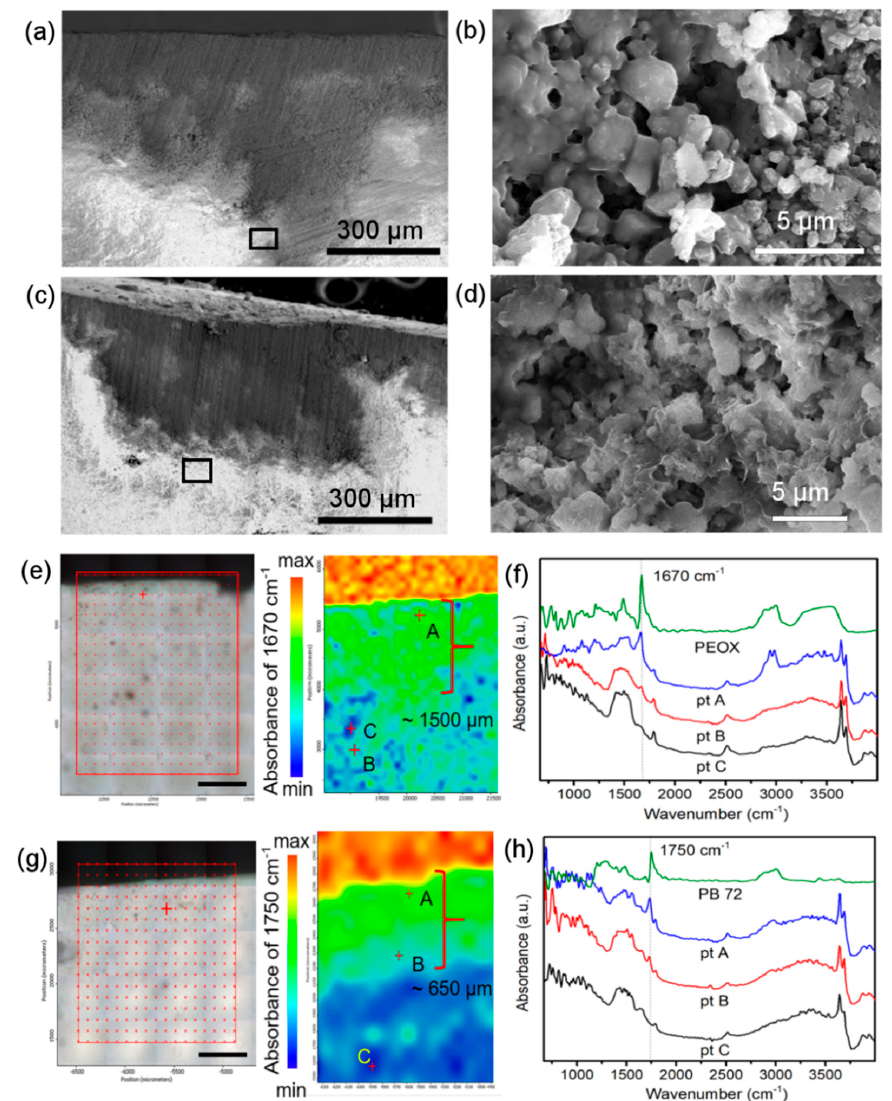
Figure 5. ( a , c ) The cross-sectional scan electron microscopy (SEM) images of the samples treated with PEOX and PB 72, respectively; ( b , d ) Magnification of the black frame in ( a , c ), respectively; ( e ) Optical micrograph of Transform Infrared spectroscopy (FTIR) mapping analysis area on PEOX treated sample and corresponding false-color map of 1670 cm − 1 . The alphabets refer to the analysis points (scale bar: 500 µm); ( f ) FTIR spectra of bulk PEOX and different analysis points in ( c ); ( g ) Optical micrograph of FTIR mapping analysis area on PB 72 treated sample and the corresponding false-color map of 1750 cm − 1 . The alphabets refer to the analysis points (scale bar: 500 µm); ( h ) FTIR spectra of bulk PB 72 and different analysis points in ( g ). (pt = point).